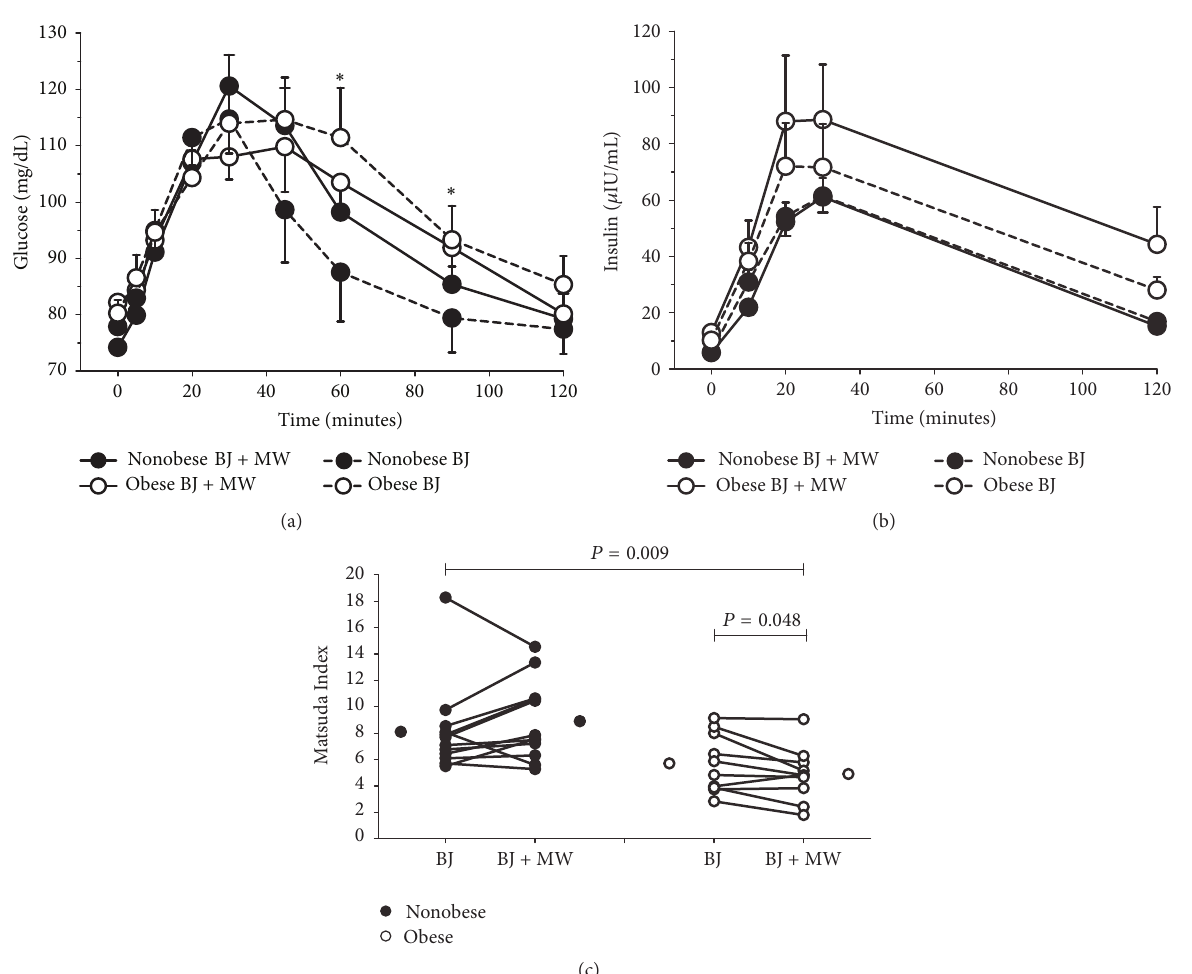
insulin concentrations and insulin sensitivity. Multiple